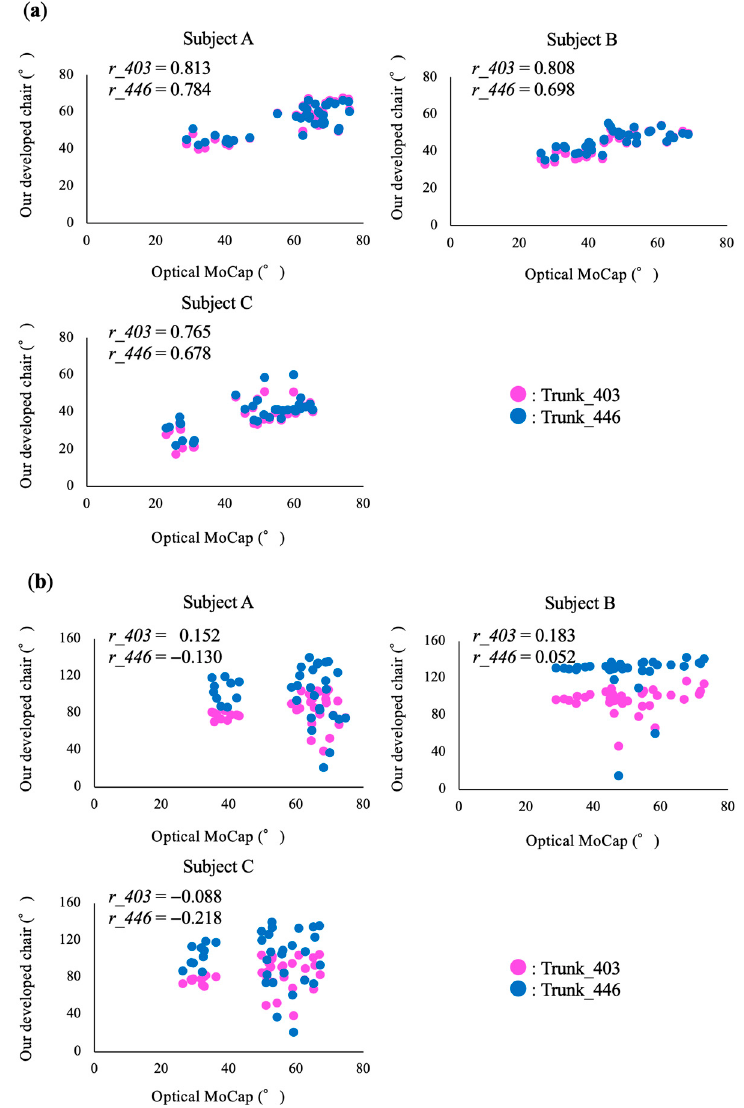
Figure 5. Scatter plots of angular excursion of ( a ) trunk flexion and ( b ) extension measured using the developed chair with embedded laser range finders and optical motion capture (MoCap) system. The chair with embedded laser range finders calculated trunk angles at two thigh-length settings, namely, 403 mm (Trunk_403) and 446 mm (Trunk_446). The correlation coefficients were calculated for each setting ( r_403 and r_446 ).